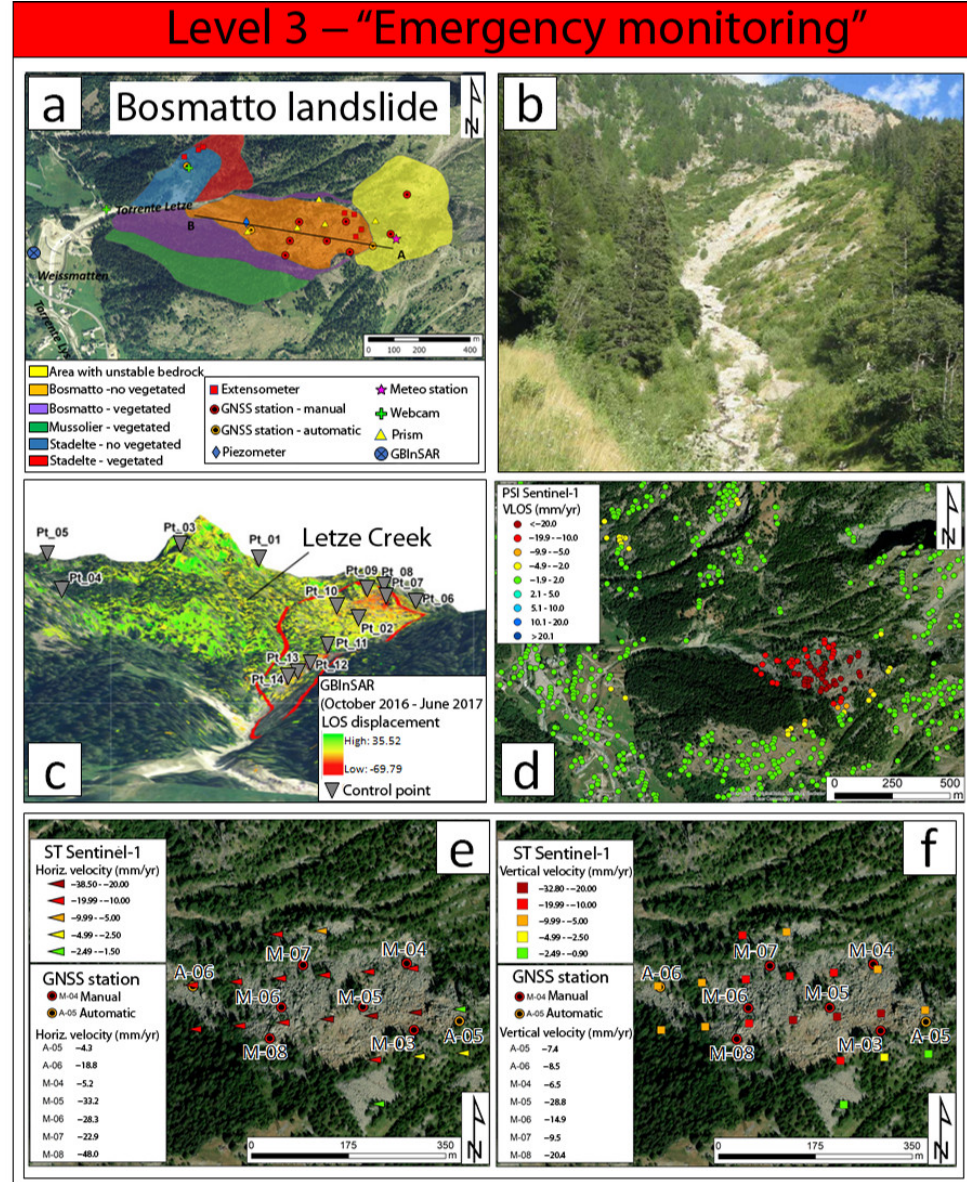
Figure 4. Level 3—“Emergency monitoring”: Bosmatto landslide: ( a ) geological map and location of instruments on the landslide; ( b ) photo of the Landslide from [41]; ( c ) ground-based interferometric radar system (GBInSAR) displacement data on the landslide; ( d ) Sentinel-1 PSI descending data on the landslide; ( e ) horizontal component of velocity of Synthetic Targets derived from PSI data and horizontal velocity recorded by global navigation satellite (GNSS) stations; ( f ) vertical component of velocity of Synthetic Targets derived from PSI data and vertical velocity recorded by GNSS